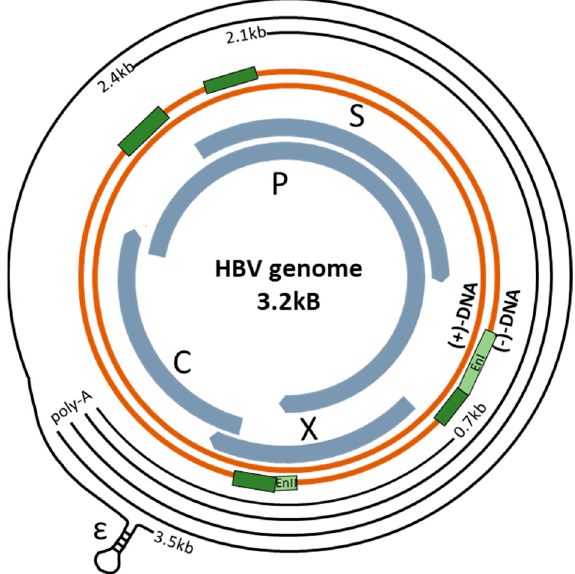
Figure 1. Schematic of the hepatitis B virus (HBV) circular genome (dark orange parallel lines). The outer black lines represent the RNA transcripts produced, all ending in the poly-A tail. The promoter regions are denoted by the dark green rectangles preceding each of these transcripts, and the Enhancer regions I and II, (EnI and EnII) are denoted by the light green rectangles. The thicker inner arrows represent the open reading frames, encoding for the C (core), P (polymerase), S (surface), and X proteins. The encapsidation signal, ԑ , is also noted.